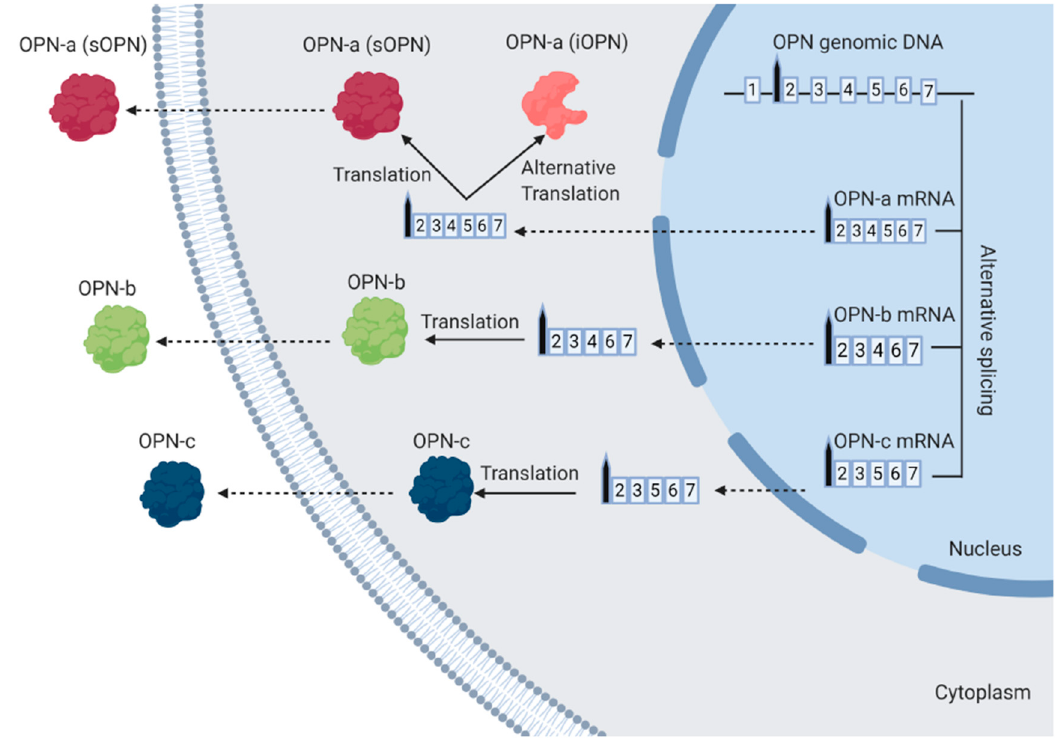
Figure 2. The generation of the di ff erent isoforms of OPN. The transcription of OPN genomic DNA produces three di ff erent splice variants of OPN mRNA, i.e., OPN-a mRNA, OPN-b mRNA and OPN-c mRNA. OPN-a mRNA contains all of the seven exons, whereas OPN-b mRNA and OPN-c mRNA lack exon-5 and exon-4, respectively. During the translation process in the cytoplasm, OPN-a mRNA produces two distinct isoforms, OPN-a (sOPN) and OPN-a (iOPN) through the AUG or non-AUG translation sites, respectively. The AUG initiates translation to produce OPN-a (sOPN), which is further modified in the endoplasmic reticulum and the Golgi complex and secreted outside the cell. The alternative non-AUG site initiates translation to generate OPN-a (iOPN), which remains inside the cell. OPN-b mRNA and OPN-c mRNA produce OPN-b and OPN-c that are secreted out from the cytoplasm. The figure was created in